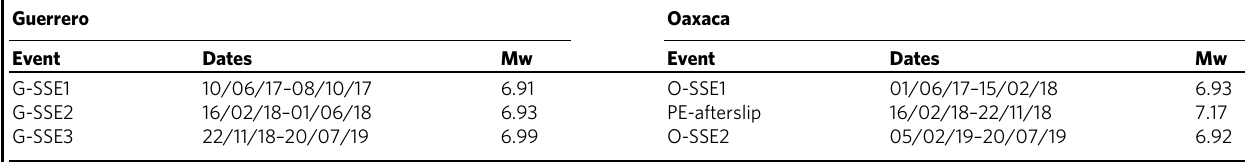
Table 1 Dates (dd/mm/yy) and moment magnitudes (Mw) estimated from the 1 cm slip contours of all aseismic slip events reported in this work.